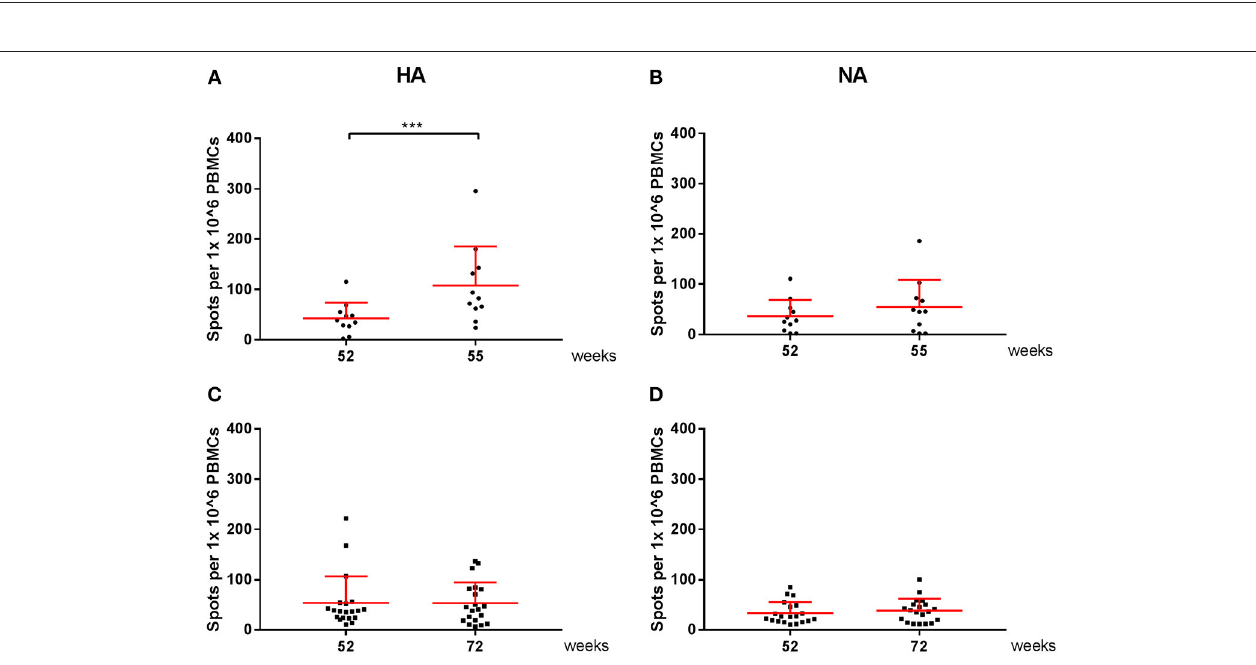
FIGURE 7 | H3N2 virus-specific cellular responses in season 2. Responses against peptide pools of A/Perth/16/2009(H3N2) HA (A,C) and NA (B,D) were measured with an IFN- γ ELISpot in individuals of the vaccine (A,B) and control group (C,D) . In red the mean and SD of each data set is depicted. ELISpot data were analyzed with Wilcoxon matched-pairs rank test. *** P <